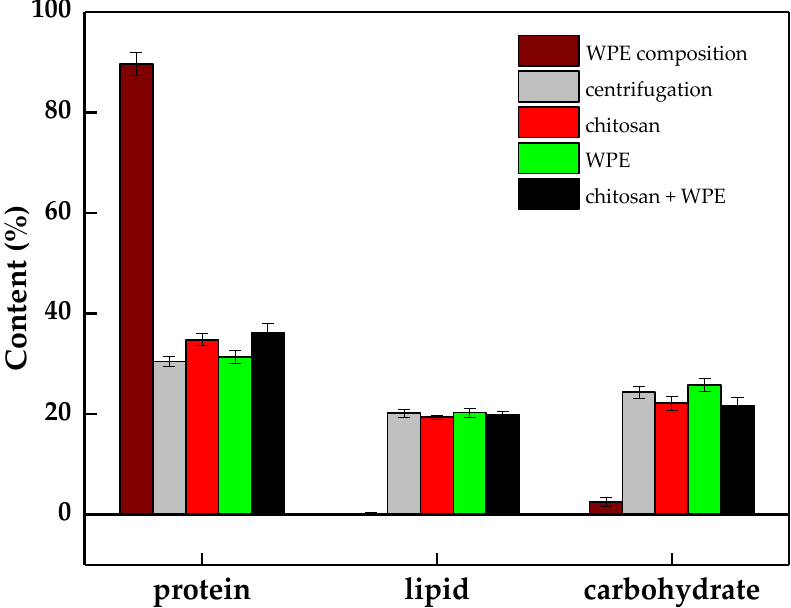
Figure 7. WPE composition extractions (protein, lipid, and carbohydrate) of microalgal cells har- vested by direct centrifugation and different flocculants. The error bars represent the standard deviation of the mean ( n = 3).